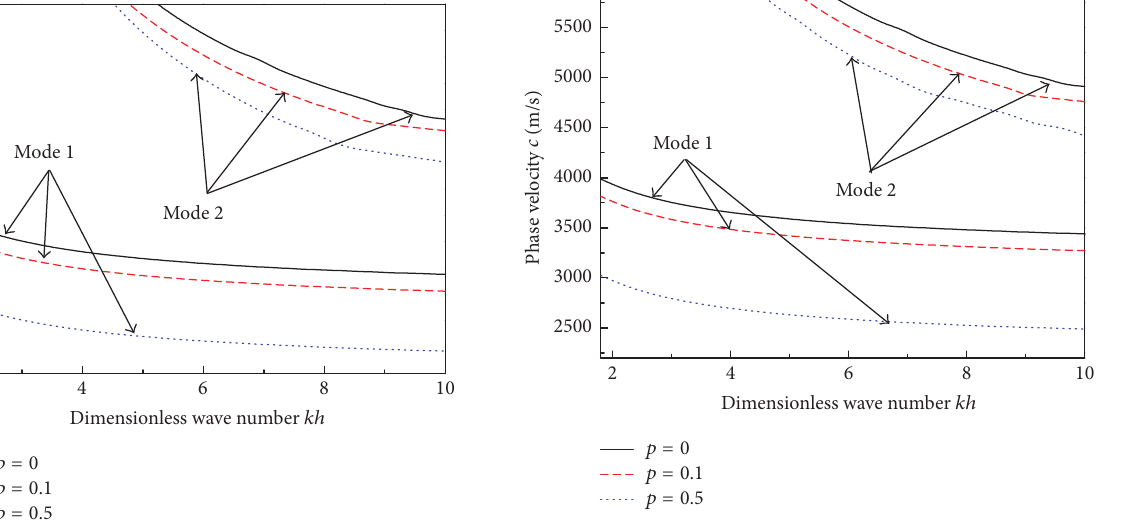
Figure 2: Comparing the dispersion relation of the SH waves with the different gradient parameter 𝑝 for Type A.